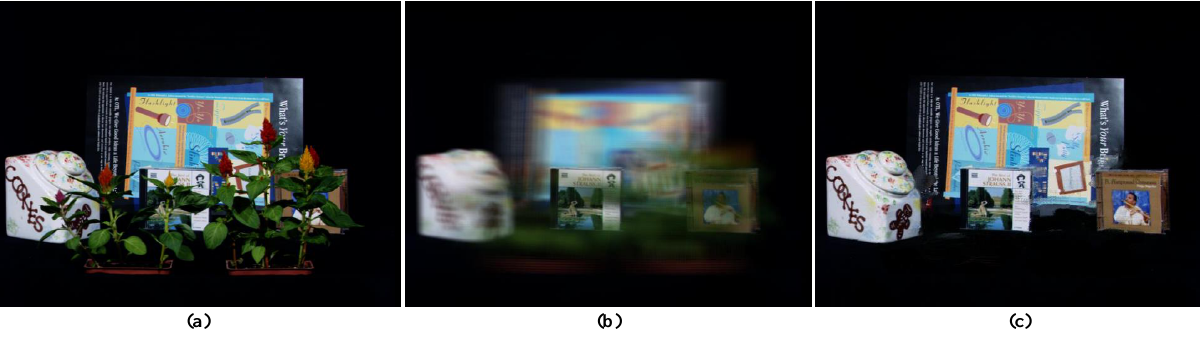
Figure 2. Comparison results of occluded object synthetic aperture imaging